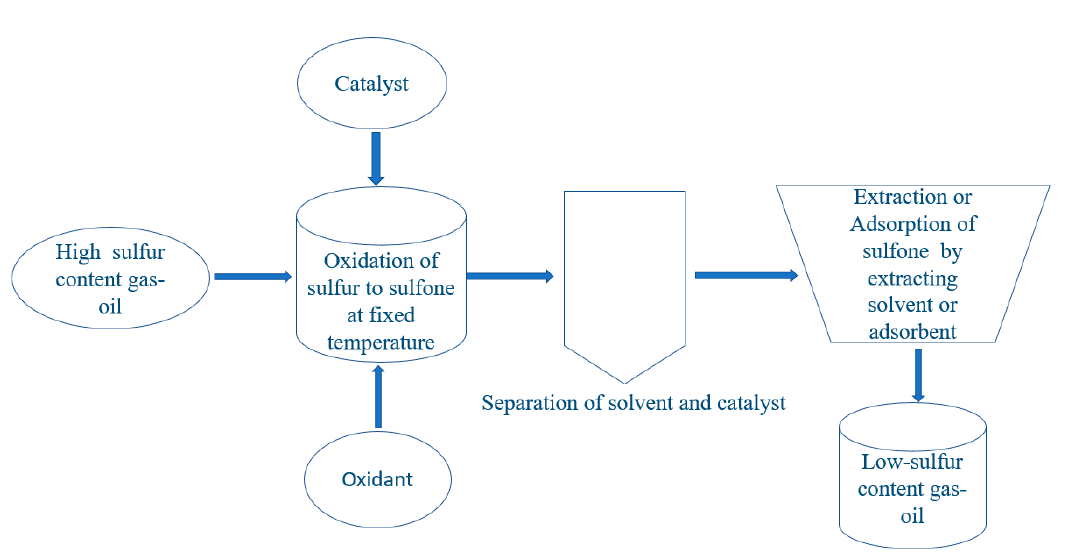
Figure 2. Classification of desulfurization technologies to remove sulfur from liquid fuel oil [21].